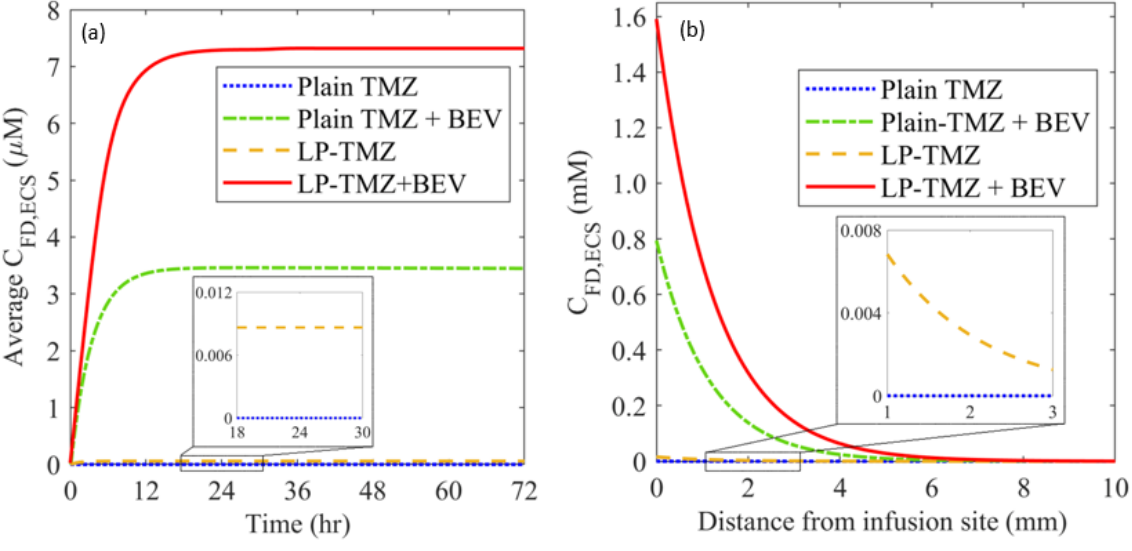
Figure A4. The ( a ) time courses, and ( b ) distance course of spatial-averaged free temozolomide con- centration in the brain tumor under different dosing regimens. The results taken on Day 3 are used to plot the distance course graph.